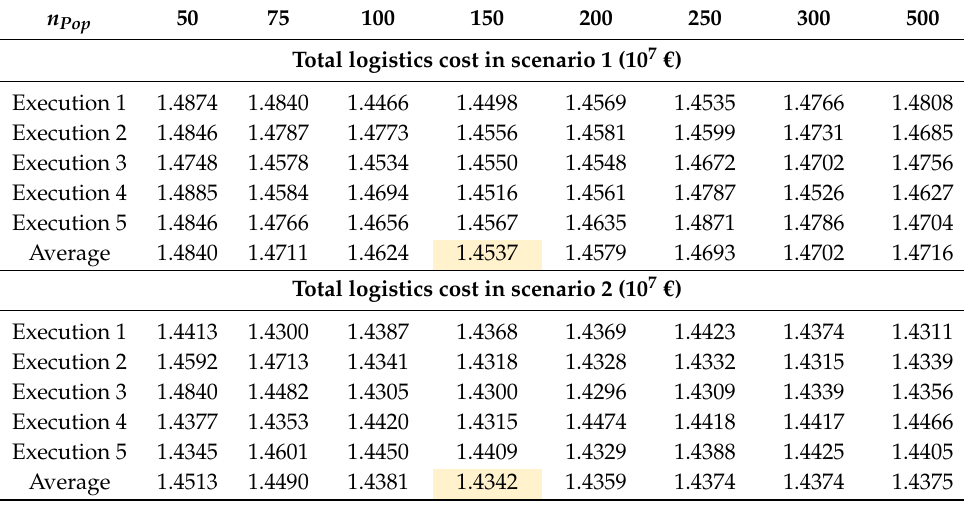
Table A5. Setting the population size for the applied genetic algorithm.